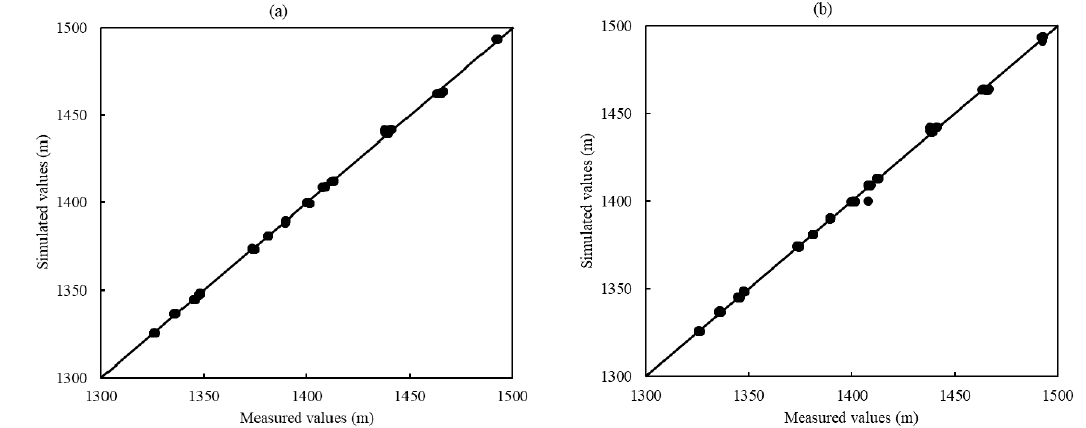
Figure 5. Comparisons of measured and simulated groundwater level during the ( a ) calibration stage and ( b ) validation stage in the Changma Irrigation District.